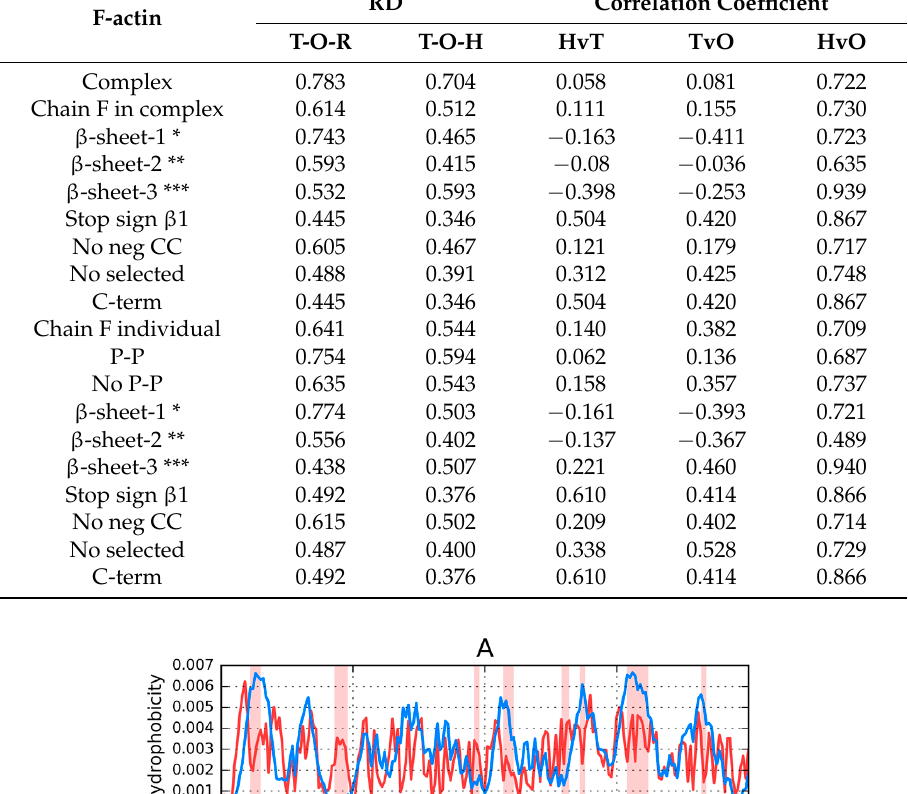
Table 8. Parameters describing the microfilament structure as present in F-actin. β -sheet-1—sheet with starting numbers 8–11, β -sheet-2—sheet with starting numbers 150–154, β -sheet-3—sheet with starting numbers 70–72. Stop sign—fragment “stopping” linear propagation: *—fragment